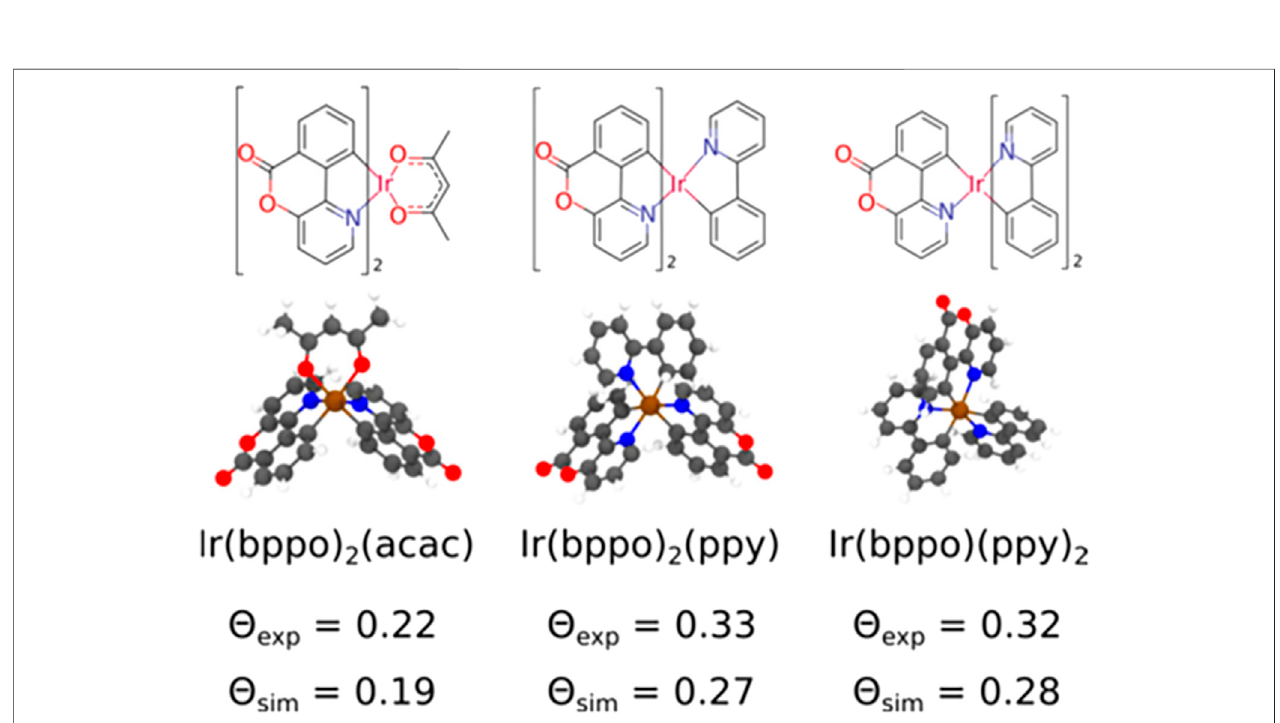
FIGURE 13 | Molecular structure of the iridium-emitters: Ir(bppo)2(acac), Ir(bppo)2(ppy), and Ir(bppo) (ppy)2, and the experimental and simulated values of the orientationparameter 2 ,whichcharacterizestheaverageorientation oftheTDMwithrespecttothe fi lmnormal, averagedin fi lmswitha10and20%dyeconcentration. Here,bppo,acac,andppyarebenzopyranopyridinone,acetylacetonate,and2-phenylpyridinate,respectively.Reprinted(adapted)withpermissionfromFriederichetal. [101]. Copyright 2017 American Chemical Society.